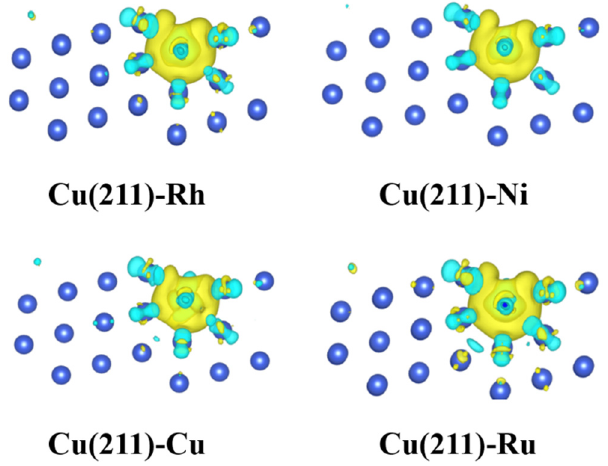
Figure 6. Side views of differential charge density distribution for M atoms (M = Rh, Ni, Co, and Ru) on Cu(211)-M surfaces. The yellow and blue regions represent charge accumulation and depletion, respectively.